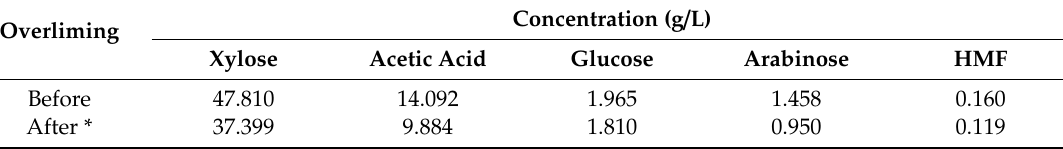
Figure 3. Kinetics of total reducing sugar for EHH obtained at 145 °C (×), 150°C ( Ο ), 155°C ( □ ), and 160 °C ( ∆ ) over different durations and at an S/L of 1:3. Lines are a guide to the eye. Table 6. cEHH obtained from extraction at 155 °C, 195 min, and an S/L of 1:2 before and after liming.